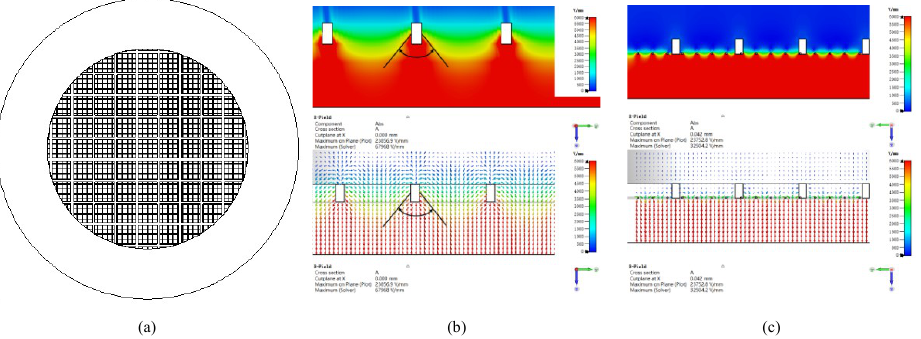
Figure 9. ( a ) Optimized structure of coarse- and fine-grid combination. ( b ) Electric field distribution and equipotential lines around the coarse-grid structure. ( c ) Electric field distribution and equipotential lines around the optimized structure.